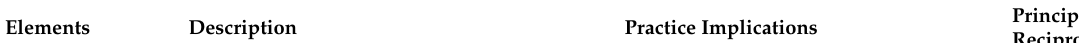
Table 1. Key Elements for